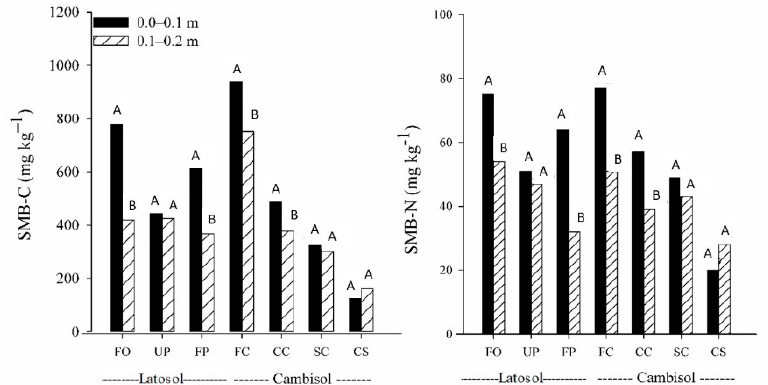
Figure 4. Soil microbial biomass carbon (SMB-C, mg kg − 1 ) and (SMB-N, mg kg − 1 ) for latosol (forest-FO, unfertilized pasture-UP, fertilized pasture-FP) and cambisol (forest-FC, pasture, coast cross-CC, sugarcane-SC, and corn silage-CS) for the surface (0.0–0.1) and subsurface (0.1–0.2 m) layers. Within each soil type / land use combination, bars with di ff erent upper-case letters are significantly di ff erent ( p < 0.05) between surface and subsurface